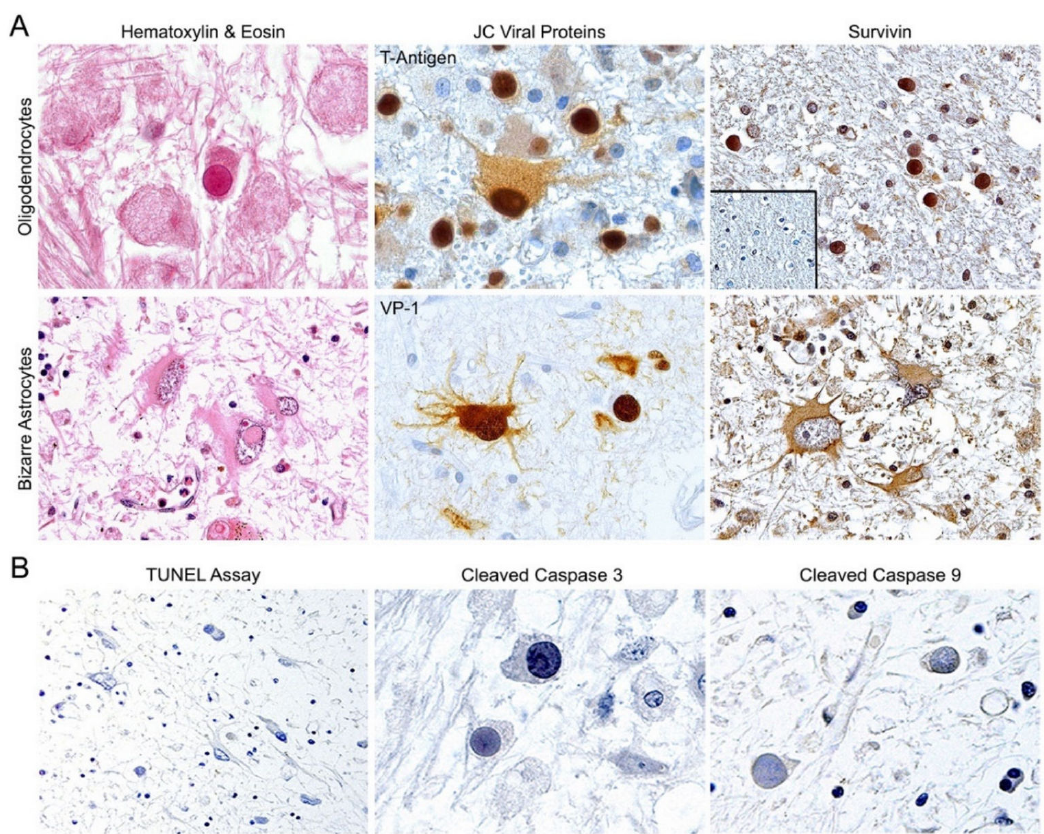
Figure 1. Expression of Survivin and absence of caspase activity in cases of Progressive Multifocal Leukoencephalopathy (PML). (Panel A ) Pathognomonic histological findings in PML include the presence of enlarged oligodendrocytes harboring intra-nuclear eosinophilic inclusions bodies (upper left panel, H&E, 1000 × magnification) and bizarre-shaped, transformed astrocytes (lower left panel, H&E, 400 × magnification) within demyelinated plaques. Expression of T-Antigen and the capsid protein VP-1 are observed in infected oligodendrocytes and astrocytes of PML lesions (middle panels, 600 × ). Immunohistochemical analysis of Survivin demonstrates the anti-apoptotic protein is abundantly expressed in both subtypes of JCPyV-infected cells, oligodendrocytes (upper panel) and astrocytes (lower panel). Importantly, no expression of Survivin was detected in normal brain, nor brains undergoing other pathologies (inset), nor in the astrocytes and oligodendrocytes in non-demyelinated plaques. Survivin is present in the nuclear inclusion bodies and cytoplasm of infected oligodendrocytes, and mostly in the cytoplasm of bizarre astrocytes (right panel, 400 × ). (Panel B ) In addition to the up-regulation of Survivin, no detection of DNA laddering (TUNEL assay) was found in any cell type of the disease (right panel, 200 × ), and the cleaved forms of caspase-3 or caspase-9 were absent in inclusion bodies of infected oligodendrocytes (middle and right panel, 1000 ×